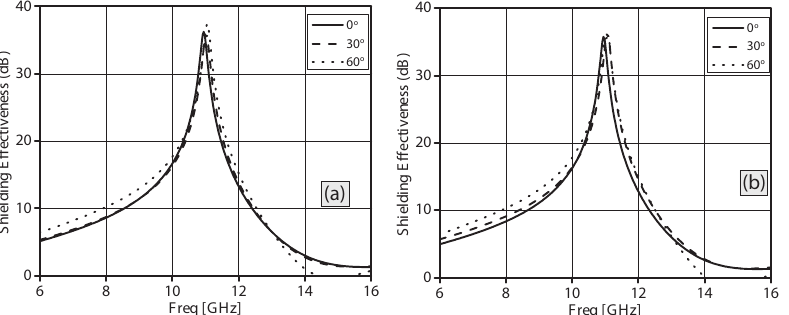
Figure 6. Shielding response of the proposed FSS at oblique angles (0 ◦ , 30 ◦ , and 60 ◦ ): ( a ) TM polarization and ( b ) TE